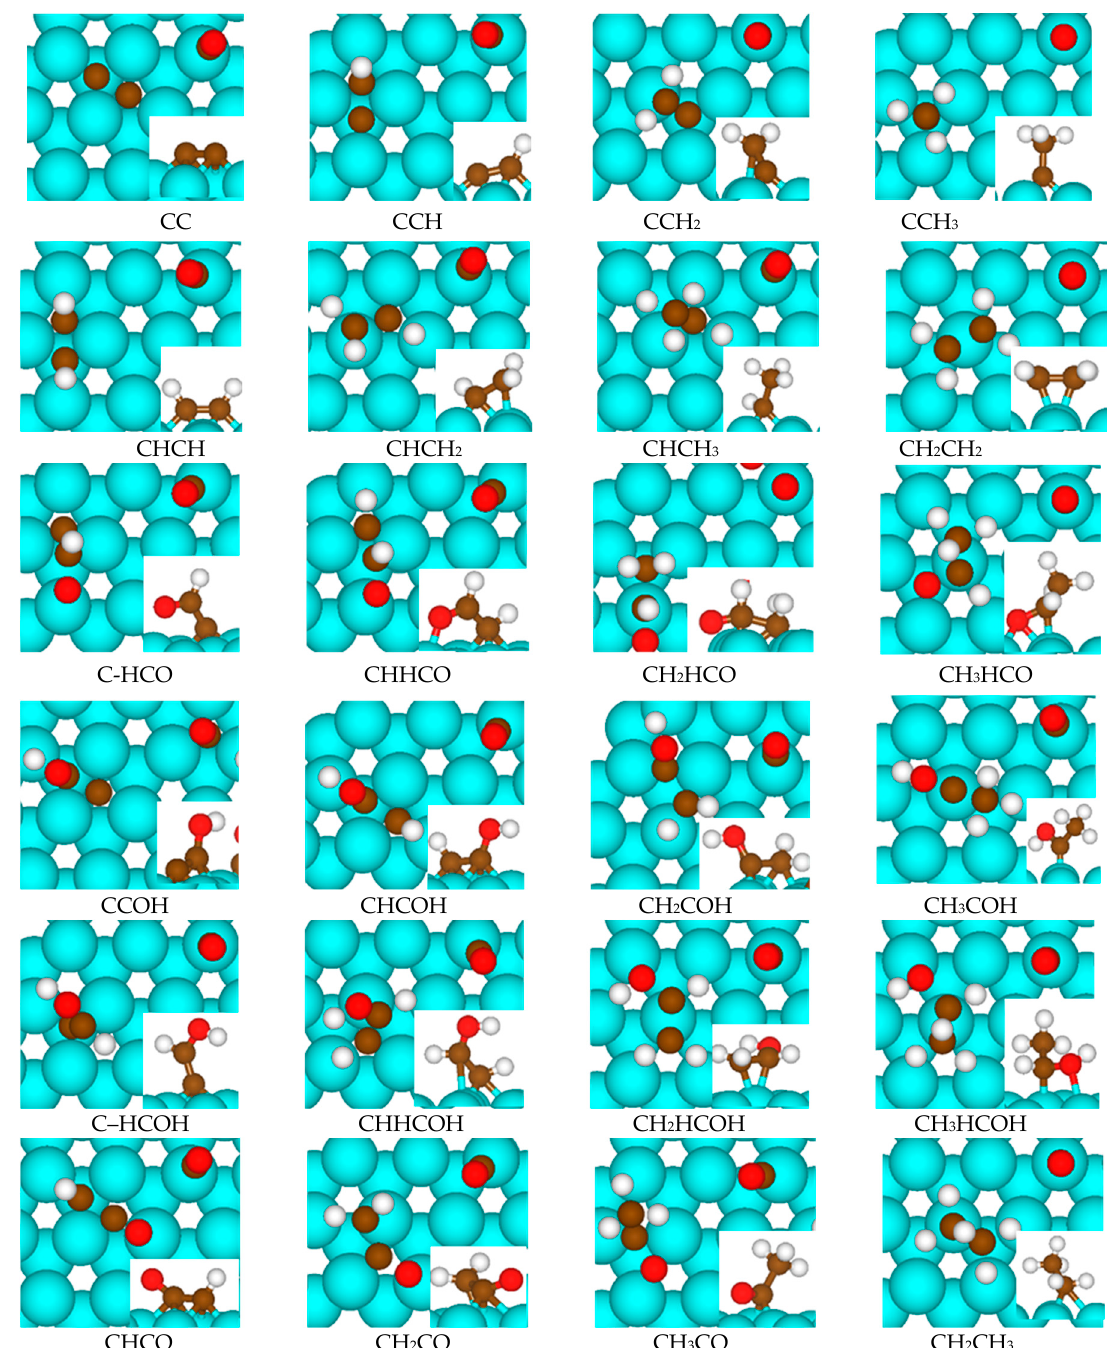
Figure 1. Top views and side views (inserted) of C 2 species adsorbed on the surface.